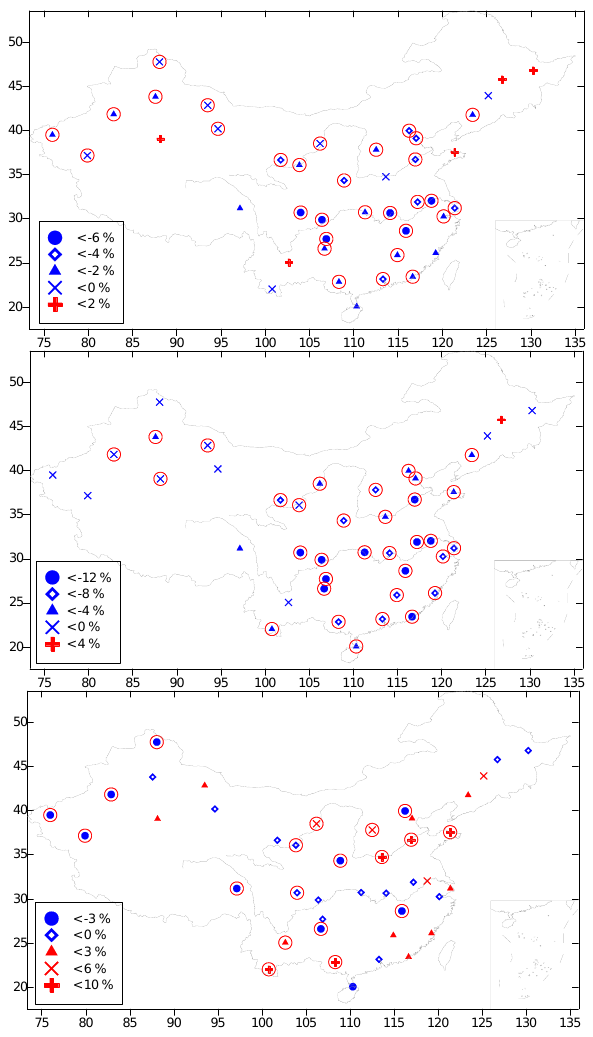
Fig. 3. The same as Fig. 1, but for annual mean sunshine duration at Figure 1. Trends in annual global irradiance (up), direct irradiance (middle) 192 meteorological stations. A significant decline in sunshine over Fig. 1. Trends in annual global irradiance (up), direct irradiance and diffuse irradiance (bottom) at 42 first-class radiation stations. They are much of China is (middle) and diffuse irradiance (bottom) at 42 first-class radiation derived from radiation data during 1961 to 2000. The magnitude is stations. They are derived from radiation data during 1961 to 2000. Figure 3. The same as Figure 1, but for annual mean sunshine duration at 192 demonstrated by different symbols. Stations with indicators with circles The magnitude is demonstrated by different symbols. Stations with meteorological stations. Significant decline in sunshine over much of China is apparent. around them are significant at the 95% confidence level. indicators with circles around them are significant at the 95% con- fidence level.